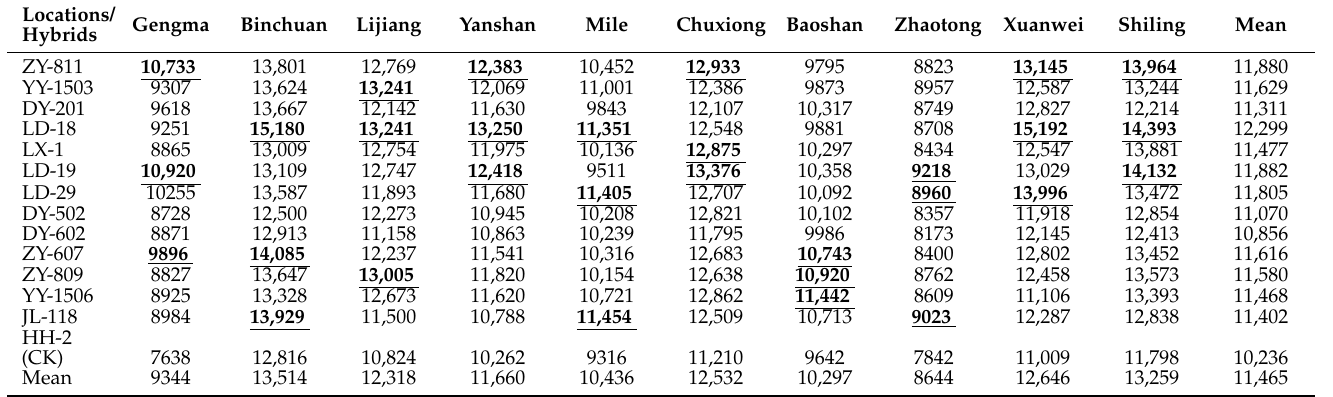
Table 7. Mean yield (kg ha − 1 ) of 14 maize hybrids across 10 environments over two years.